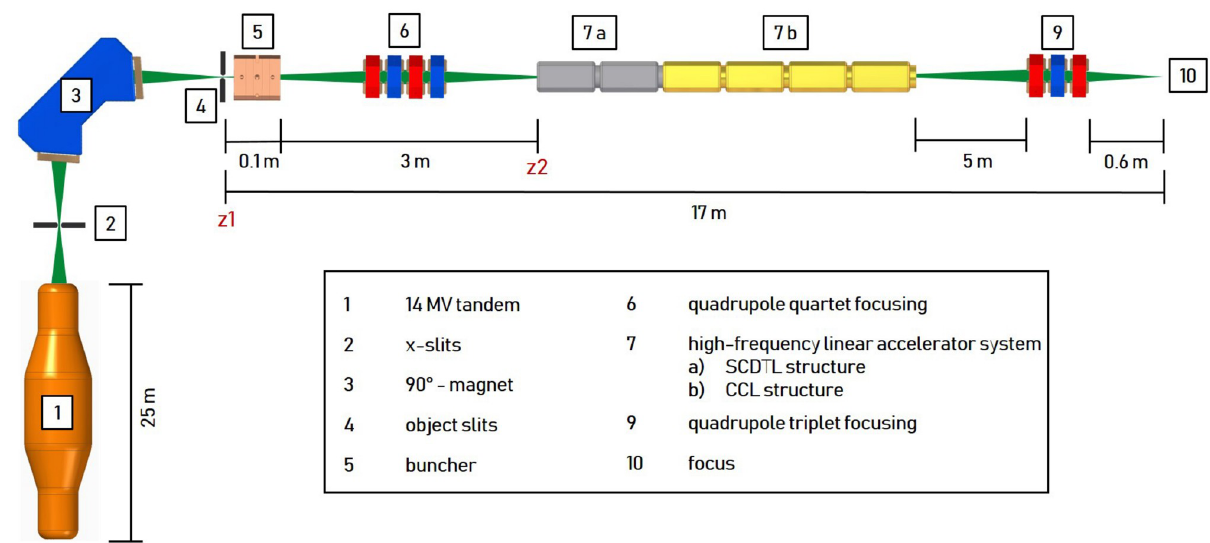
Fig 1. Concept of the preclinical proton minibeam irradiation facility. A 16 MeV proton beam provided by a tandem is accelerated to 70 MeV by a radio-frequency linac system and subsequently focused to 0.1 x 0.1 mm 2 by a quadrupole triplet. The 6-dimensional phase space of the tandem beam is matched to the accepted phase space of the linac by a buncher unit and a quadrupole quartet.